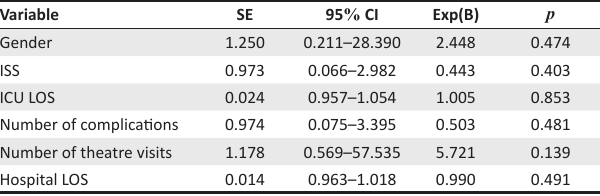
TABLE 5: Binary logistic regression model assessing variables and their effect on non-independent physical function (FSS-ICU score < 35) at hospital discharge.